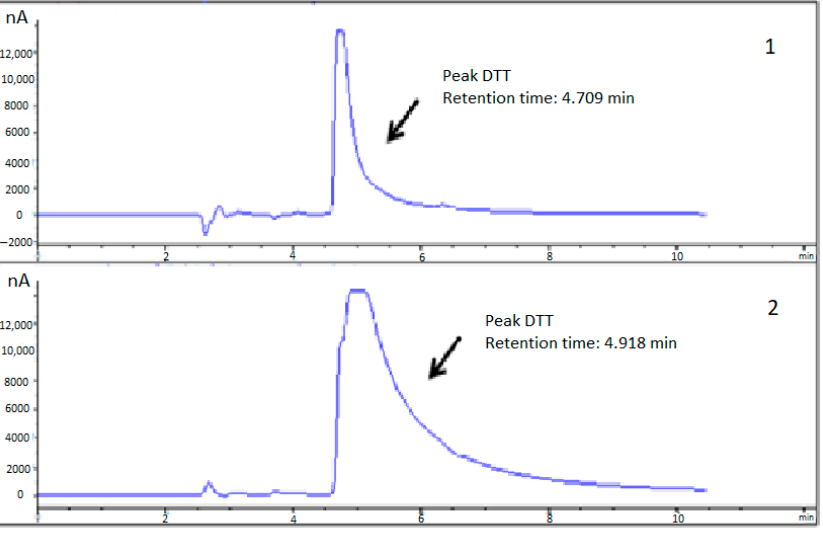
Figure 3. Chromatogram of a 100 mM DTT standard: ( 1 ) Oxidation potential (+410 mV) and ( 2 ) Reduction potential ( − 350 mV) .